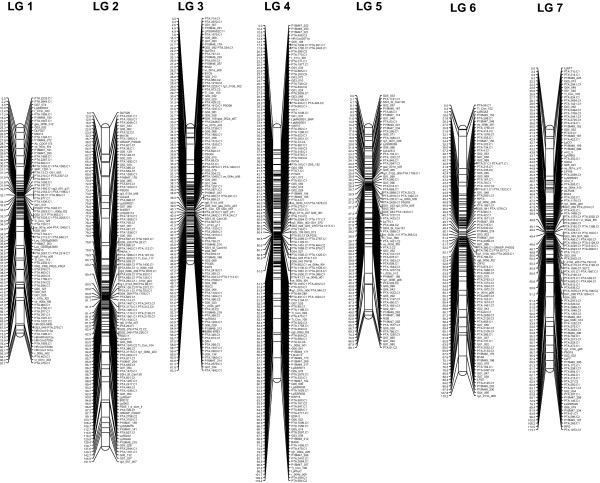
Transcriptome map of perennial ryegrass (Lolium perenneL.). The EST-based SNPs developed in this study were used to map 495 ryegrass unigenes in the VrnA mapping population using the Haldane mapping function of JoinMap version 4.0 [55]. Linkage groups (LG) were numbered according to the nomenclature accepted for Triticeae, scale units are given in centi Morgan (cM). The resulting VrnA transcriptome map contained 838 DNA markers, ranging from 87 on LG 5 to 168 on LG 4 with an average of 120 markers per LG. Out of these, 767 are EST-derived SSRs, SNPs or CAPS marker. The total map length was 750 cM, spanning from 63 cM on LG3 to 151 cM on LG 2 (mean LG length of 107 cM). The average marker distance was less than 0.9 cM.